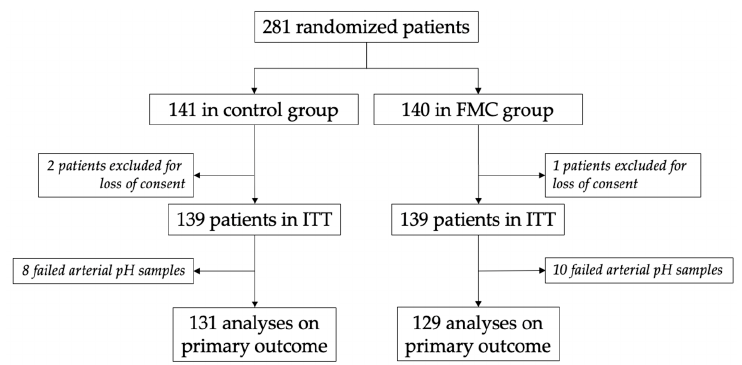
Figure 1. Flow chart. FMC: fetal movements counting; ITT: intention-to-treat. The demographic characteristics of the patients are presented in Table 1. No differences were found between the two groups for maternal and obstetric data. Table 1. Demographic characteristics. Data are expressed as n (%) or means +/ − standard deviations. FMC Group (n =